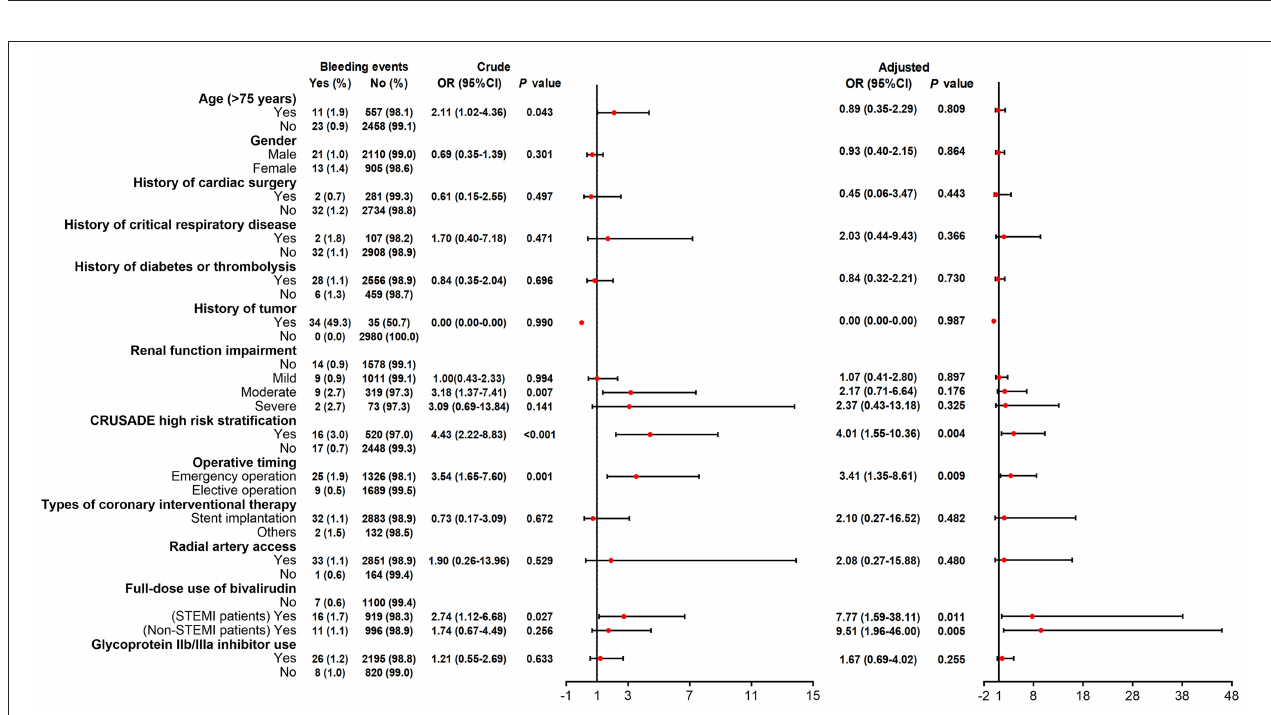
( Supplementary Table 6 ). The detailed information of AEs, ADRs, and new ADRs could be referred to Table 3 and Supplementary Tables 4, 6 ,